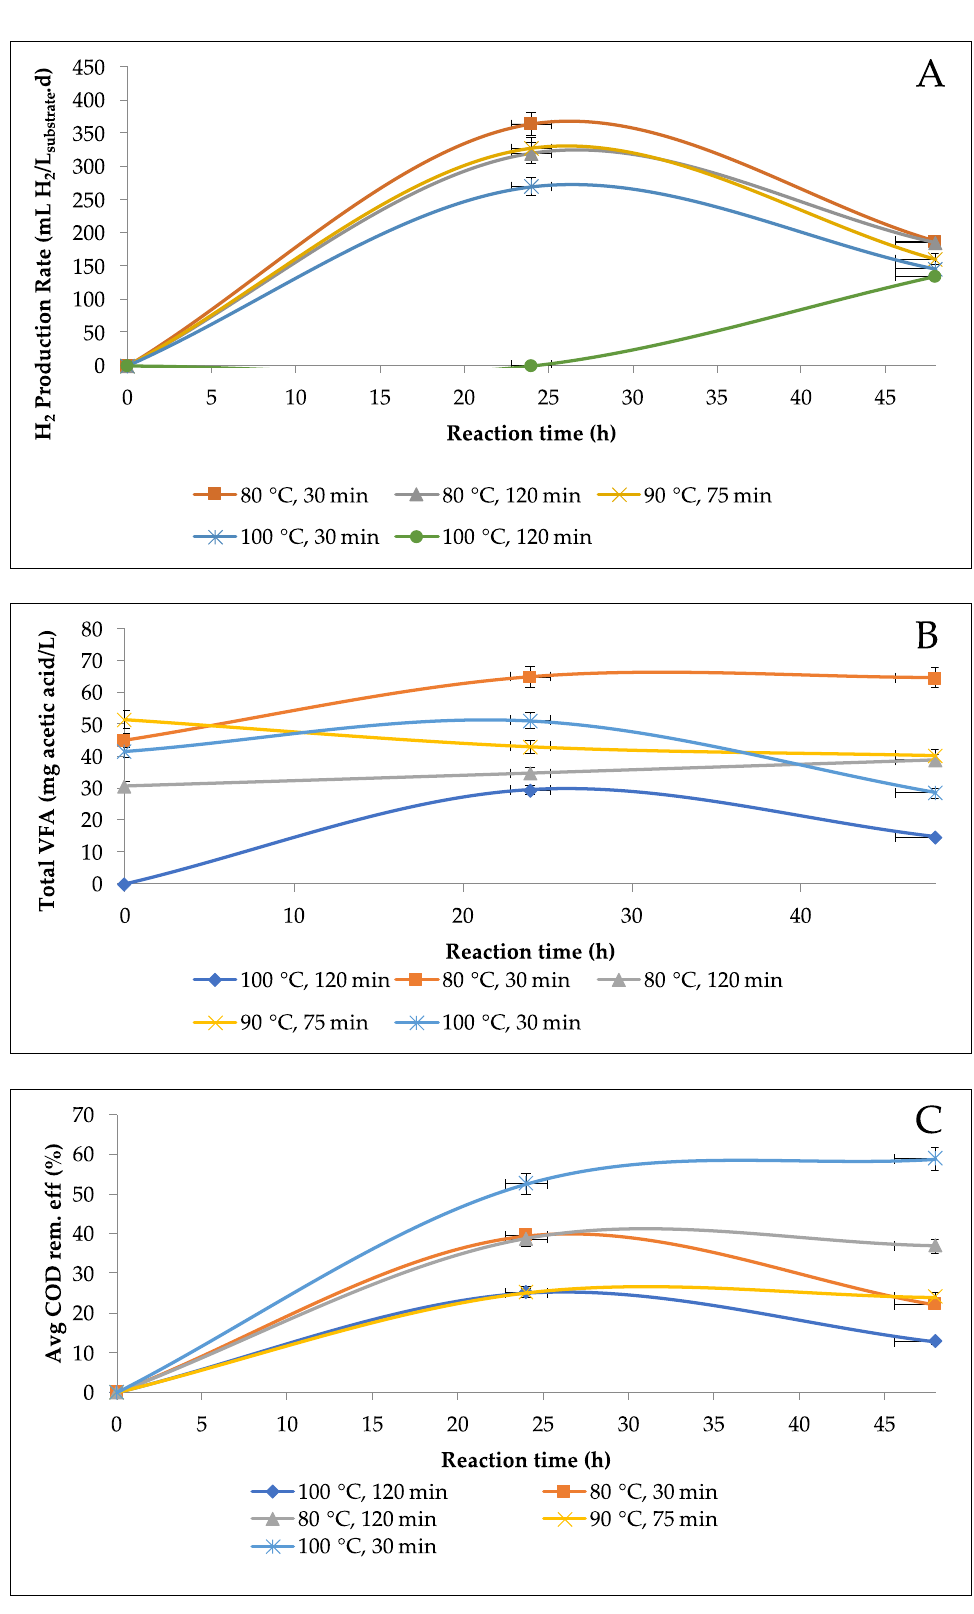
Figure 4. Results from heat treatment strategy (First Phase) using Carlsberg anaerobic granulated sludge as inoculum fed with 6 g COD/L glucose. ( A ) Average hydrogen production rate versus time. ( B ) Average total VFA versus time. ( C ) Average COD removal efficiency versus time. (Average results were calculated based on sample size, n = 3).